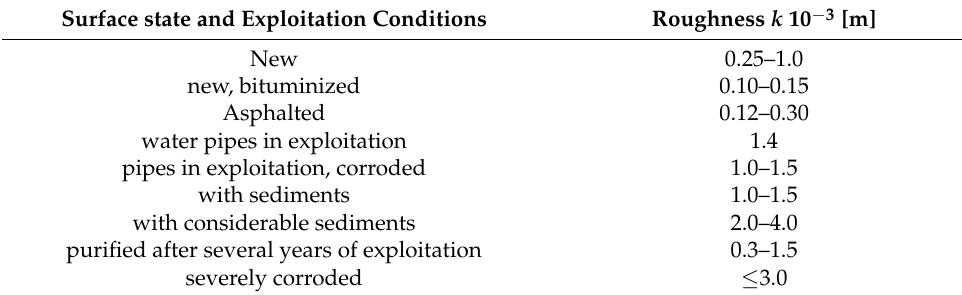
Figure 3. Pressure difference ∆ p calculated for the cast-iron pipes with the internal diameter d = 150 mm according to the standard [49] and measured for the new pipe and pipes after 30-year exploitation. Table 2. Absolute roughness coefficient k for cast-iron pipes